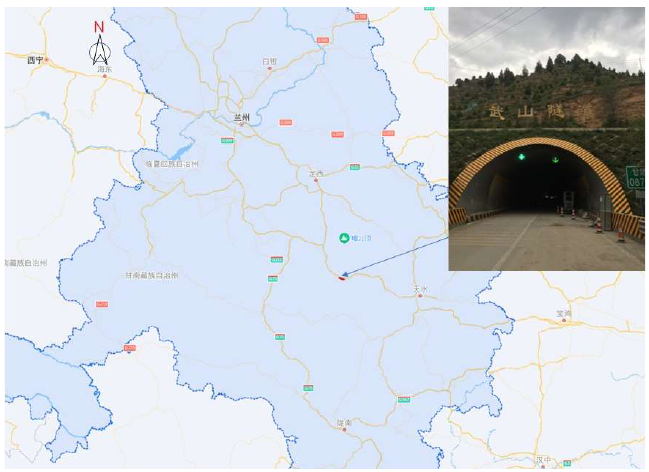
Figure 1. The Wushan Tunnel.